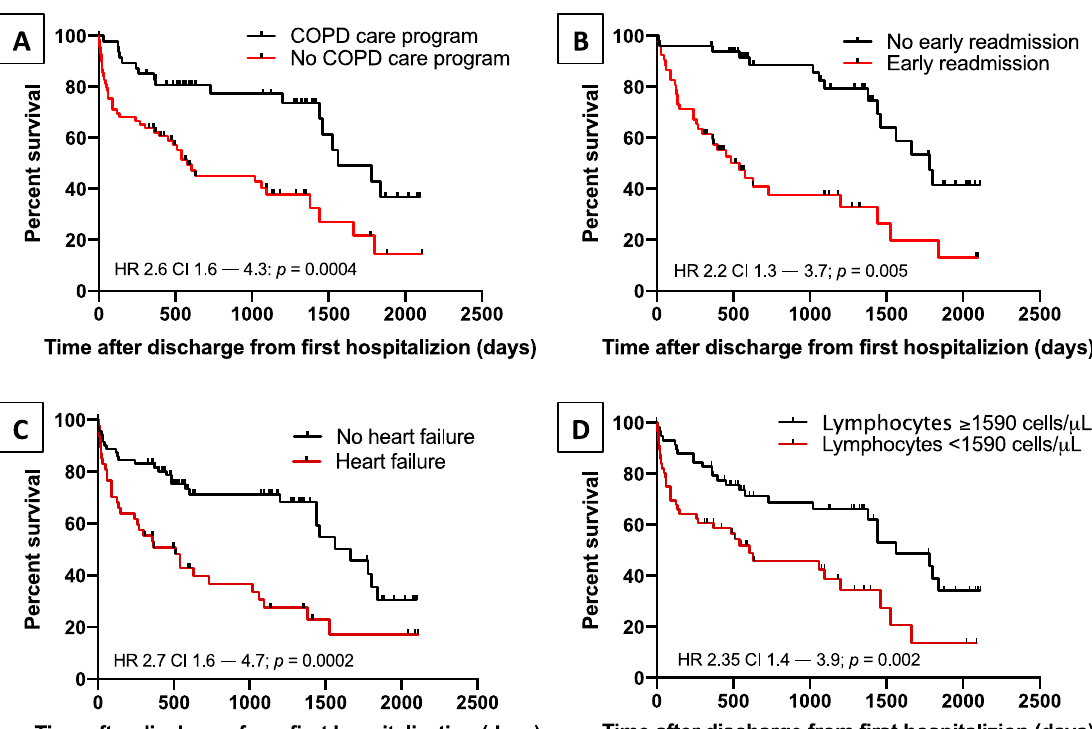
Figure 5. Risk factors for mortality. Kaplan–Meier plots showing the e ff ect on survival of: lack of inclusion in a COPD care program ( p = 0.0004, panel ( A )); early readmission for COPD exacerbation ( p = 0.005, panel ( B )); heart failure at hospitalization ( p = 0.0002, panel ( C )); and low blood lymphocytes count ( p = 0.002, panel ( D )). Table 4. Risk factors for death, Cox proportional hazards model. Univariate Analysis Cox Regression Risk Factor p Value HR 95% CI p Value Lack of inclusion in a COPD care program 0.001 2.56